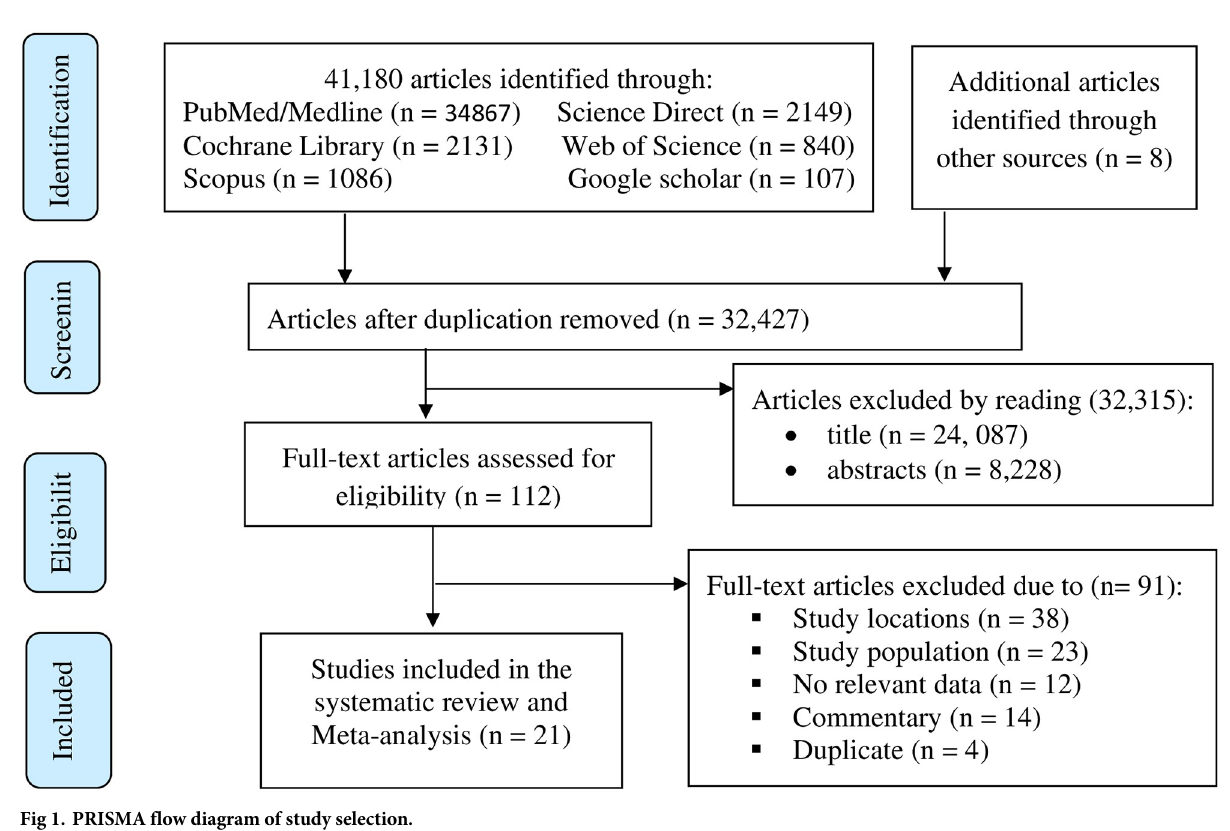
Fig 1. PRISMA flow diagram of study